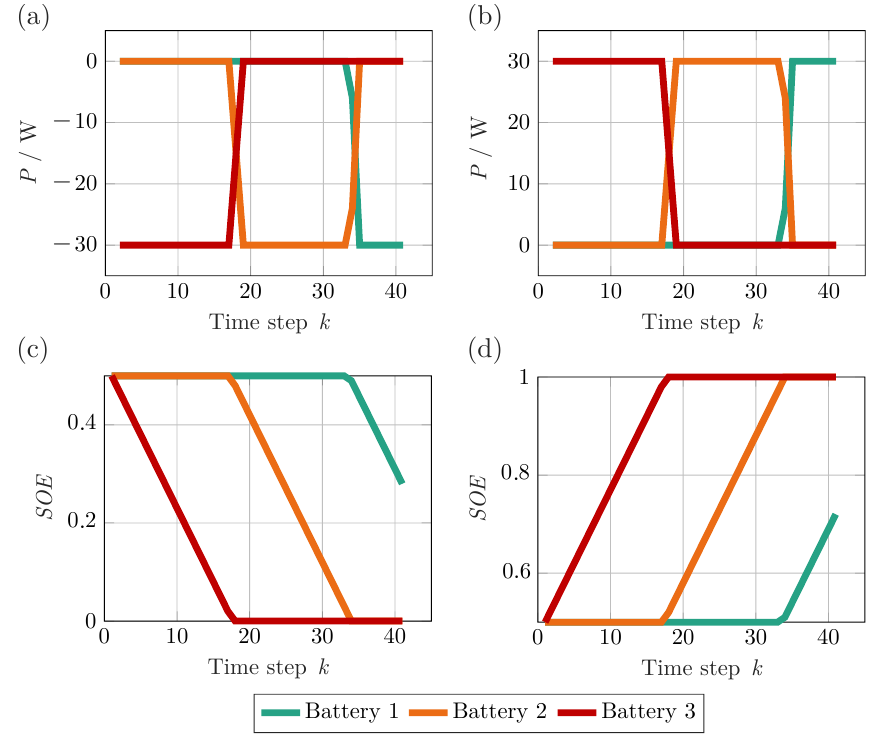
Figure A4. Optimal decision variables for the discharging ( a ) and charging ( b ) cases, as well as optimal states of the discharging- ( c ) and charging ( d ) cases of the boundary value